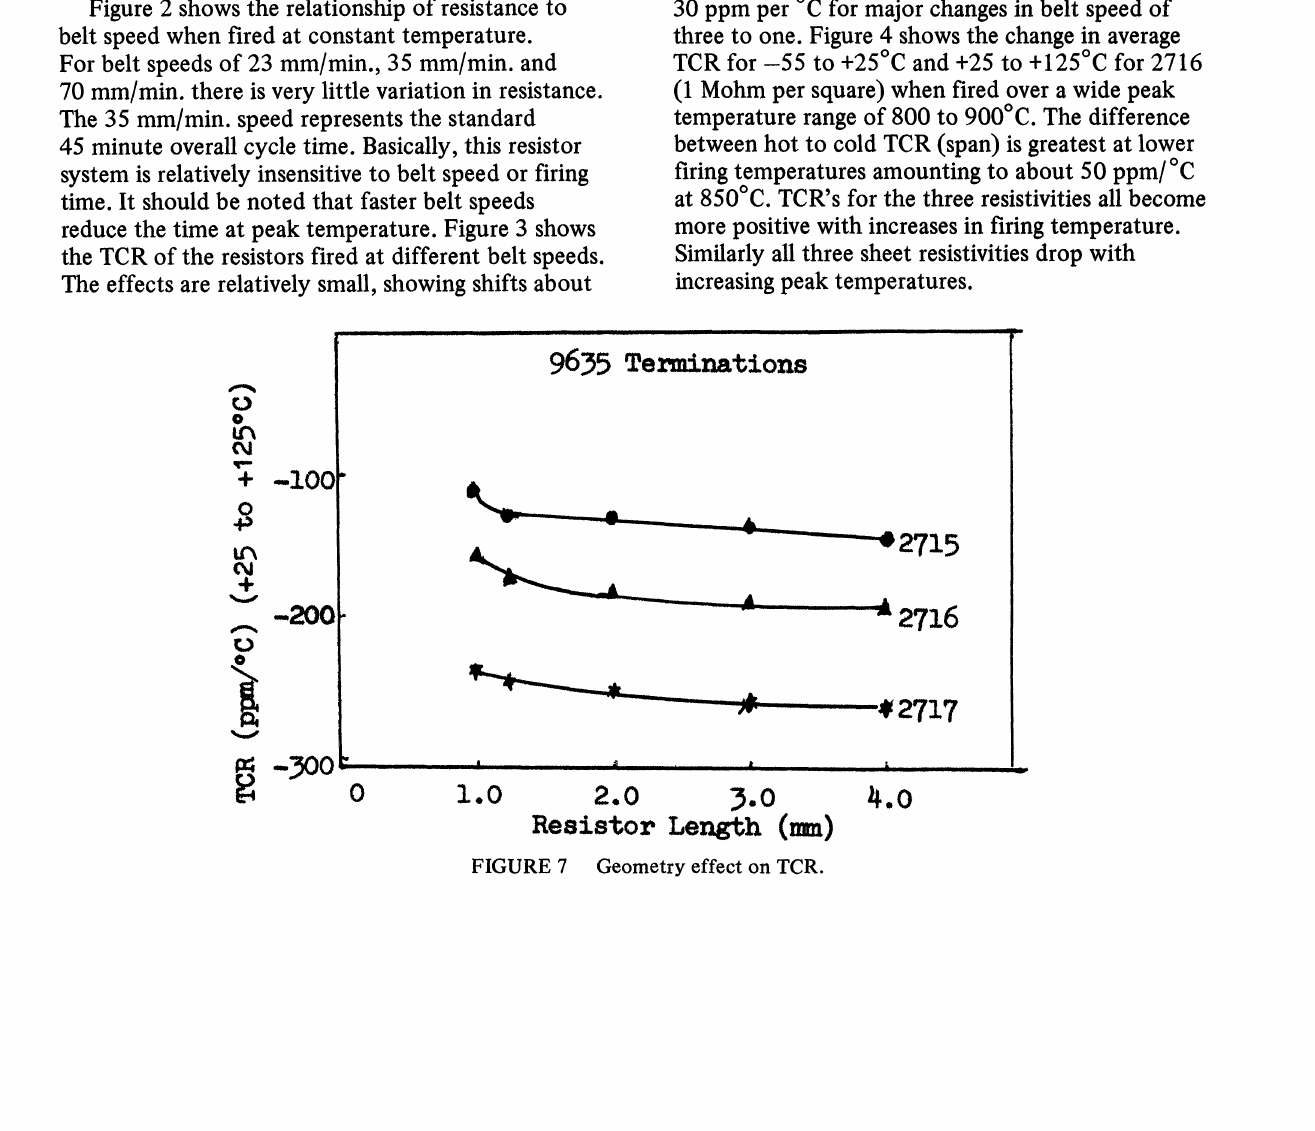
FIGURE 7 Geometry effect on